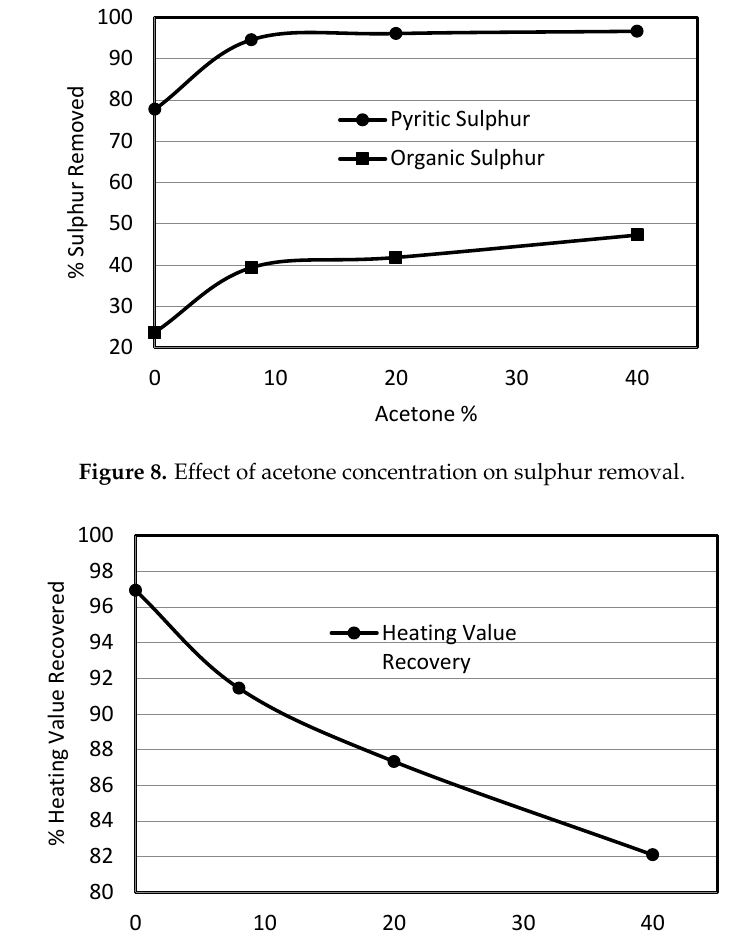
Figure 9. Effect of acetone concentration on heating value recovery.